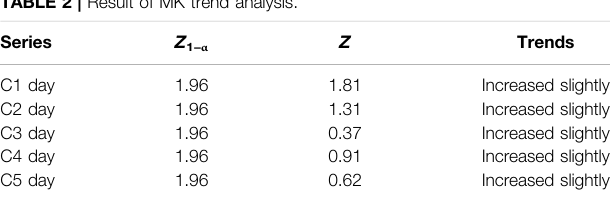
TABLE 2 | Result of MK trend